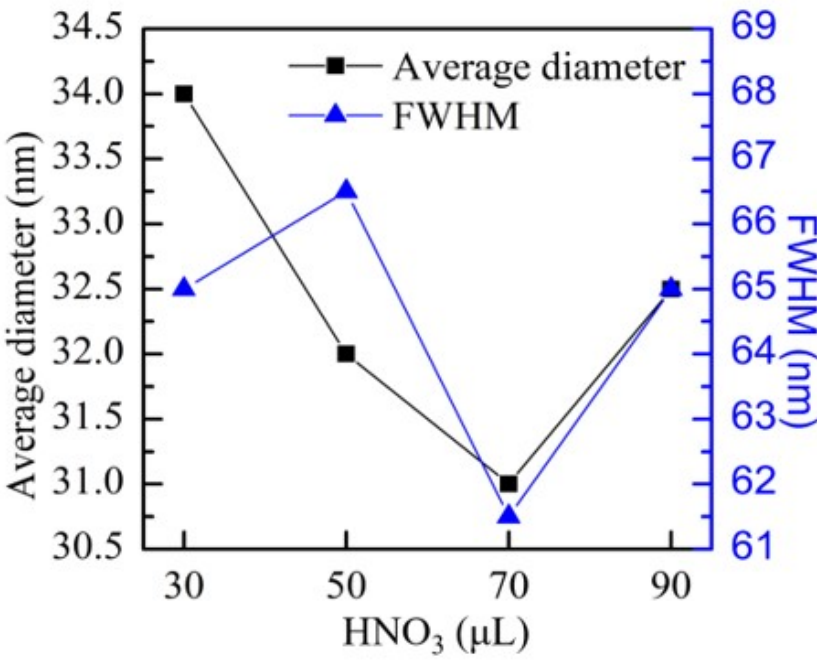
Figure 3. Average diameter and full width at half maximum (FWHM) of GNP solutions obtained at different HNO 3 additions of 30, 50, 70, and 90 μ L within a growth solution.